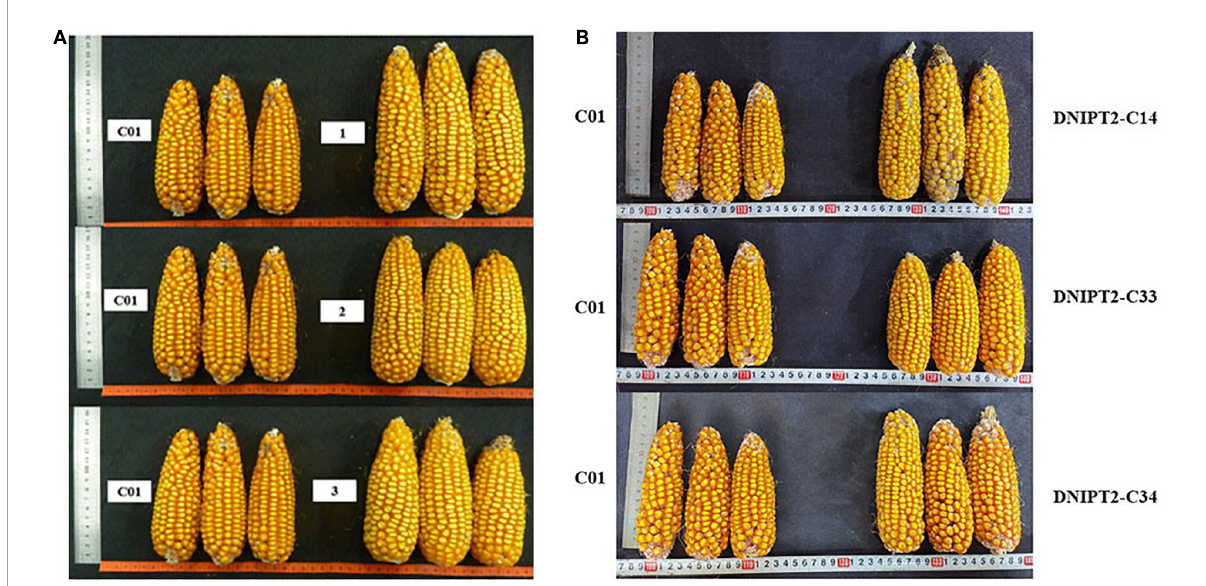
FIGURE4 The ear and grain of transgenic maize lines with ZmIPT2 gene and the receptor line C01. (A) The ear of T2 transgenic maize lines with ZmIPT2 gene and the receptor line C01. (B) The ear of T3 transgenic maize lines with ZmIPT2 gene and the receptor line C01. C01, negative control; 1, DNIPT2-C24; 2, DNIPT2-C33; 3,